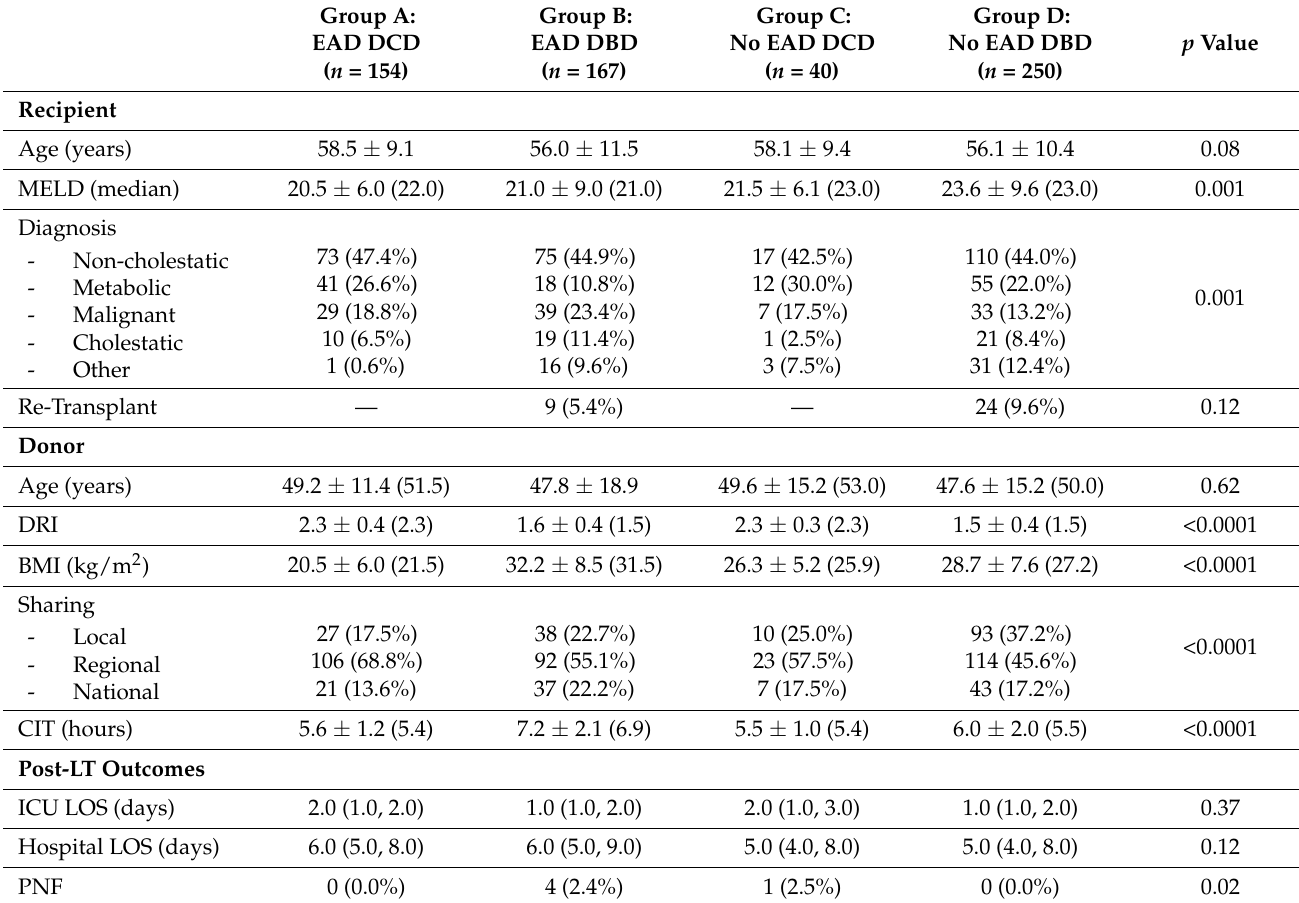
Table 4. Subgroup analysis comparing EAD in DCD and DBD grafts.